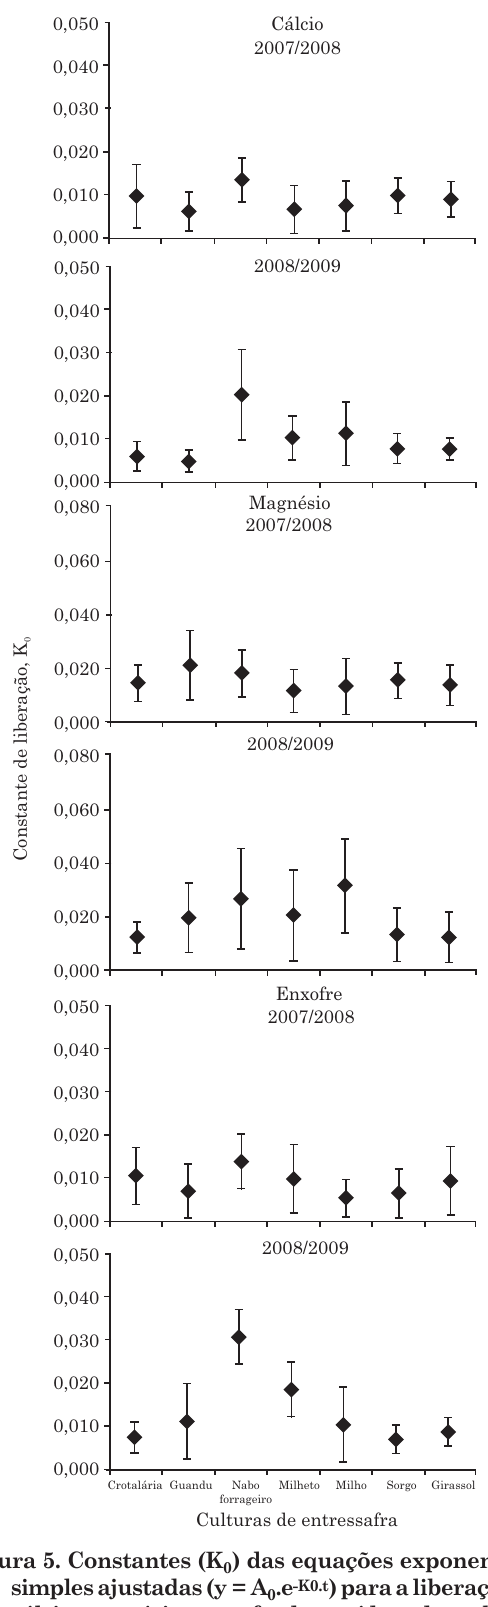
Figura 5. Constantes (K 0 ) das equações exponenciais simples ajustadas (y = A 0 .e -K0.t ) para a liberação de cálcio, magnésio e enxofre dos resíduos das culturas de entressafra. As barras verticais representam o intervalo de confiança do parâmetro K 0 a 5 %.